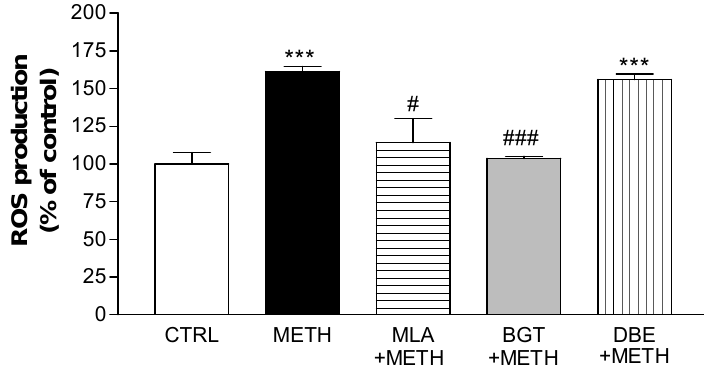
Figure 4. ROS induction by METH in striatal synaptosomes and its inhibition by α 7 nAChR antagonists [29] (MLA and α -bungarotoxin, BGT). The α 4 β 2 antagonist dihydro- β -erythroidine (DBE) was devoid of